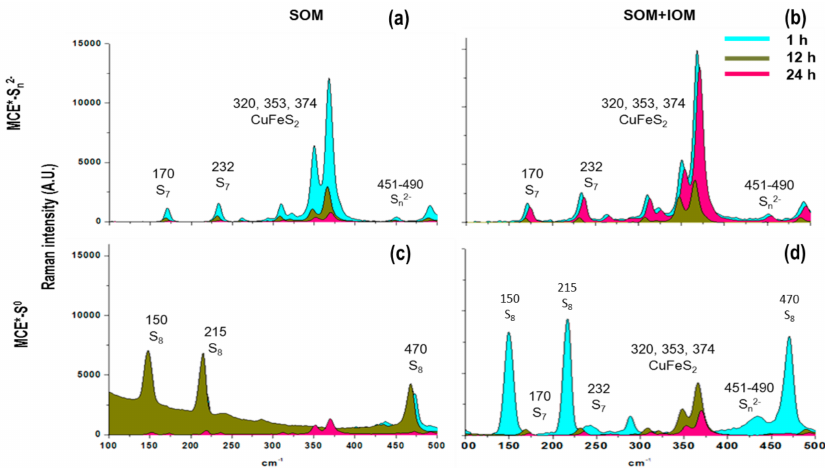
Figure 2. Identified Raman transitions peaks in terms of main surficial reduced sulfur species (RSS) on MCE*-S n 2 − interacting with SOM ( a ) and on MCE-S 0 with SOM and SOM+IOM ( b , c ) after the assayed times: 1 (blue), 12 (red) and 24 h (green). Abiotic controls ( d